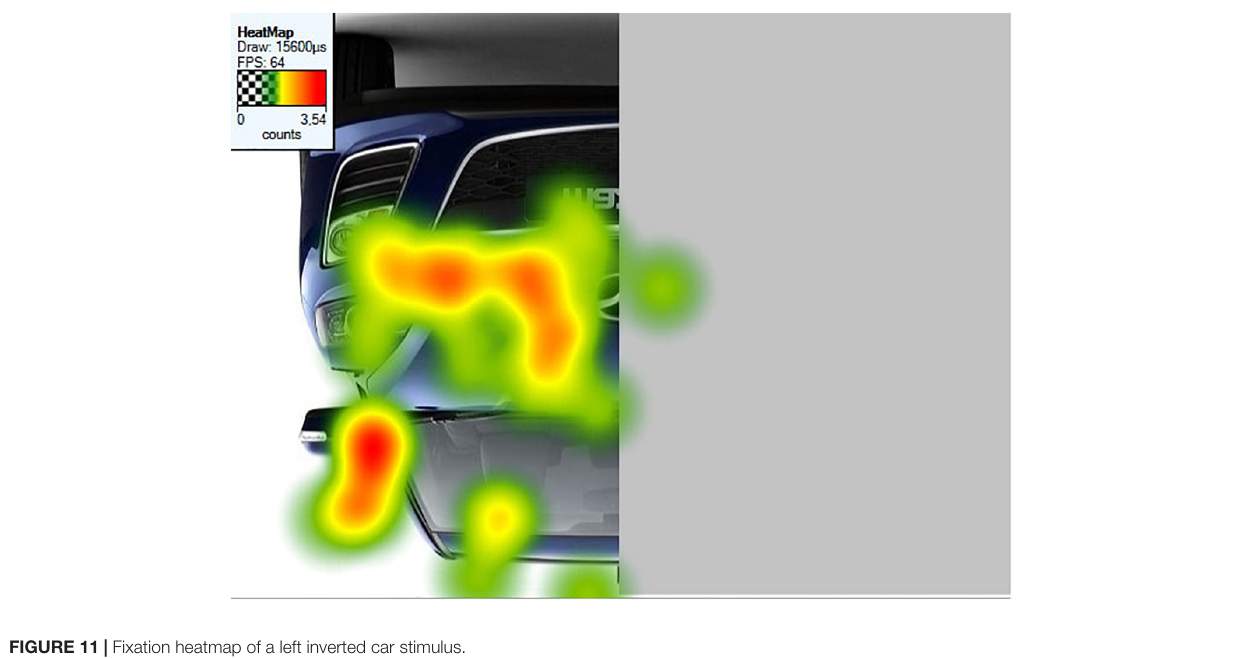
FIGURE 11 | Fixation heatmap of a left inverted car stimulus.